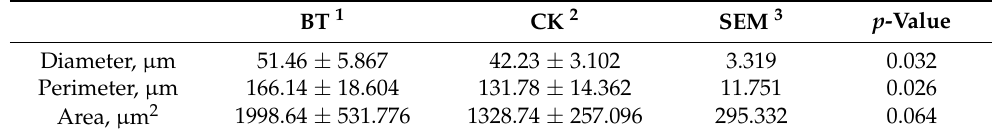
Table 1. The muscle fiber characteristics of Black Tibetan and Chaka